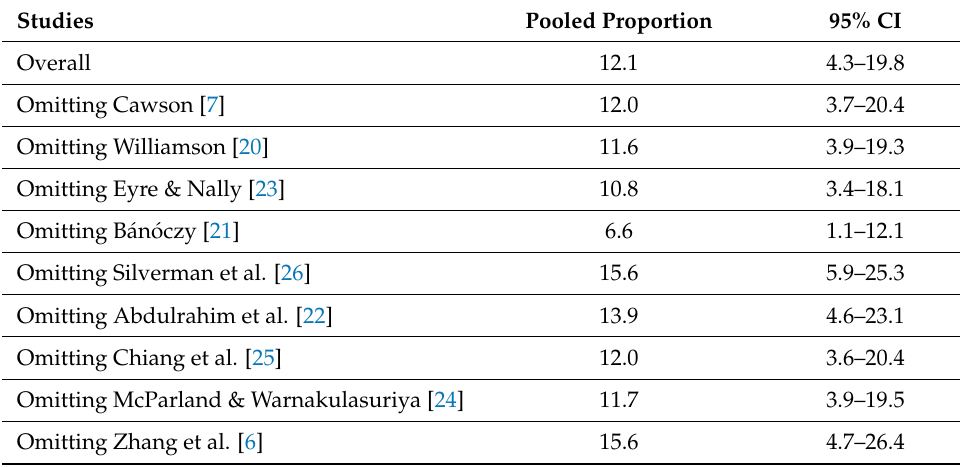
Table 4. Leave-one-out pooled prevalence